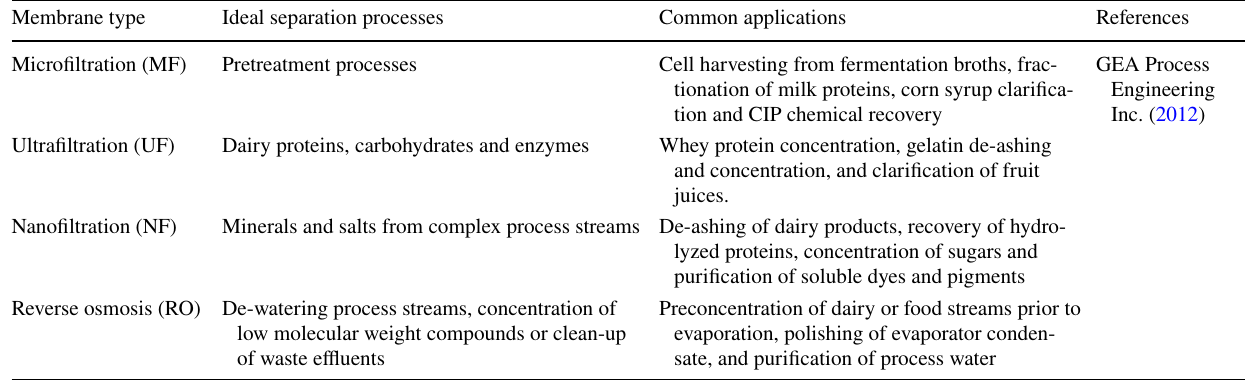
Table 3 Various membrane processes for water treatment Membrane type